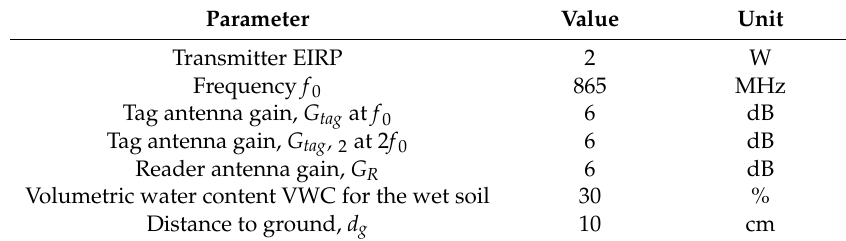
Figure 13 . Simulated received power at tag and reader for dry (solid lines) and wet soil (dashed lines). Table 1. Parameters used in the read range simulations. EIRP—equivalent isotropic radiated power; VWC—volumetric water content.